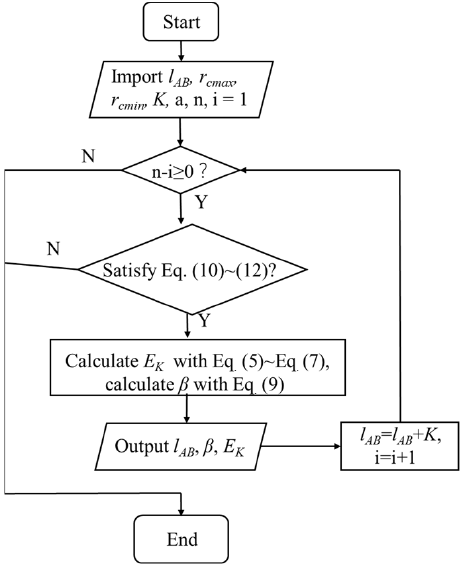
Figure 9. Flow chart of grabbing mechanism parameter optimization. Less than 1mm of the grasping error is enough for harvesting the hydroponic Chinese kale [27]. On the basis of preliminary tests, θ is set as 60 ◦ , a is 36mm, K is 5mm, n is 20, and initial l AB is 50mm. In Table 1, the r cmin and r cmax of the grabbable area of the hydroponic Chinese kale are 3.60 mm and 8.30 mm, respectively. The optimization program was run according to the flow chart in Figure 9, and iterative results of l AB , β , and grasping error E k are shown in Table 2. It shows that with an increase in the iteration times, the grasping error decreases; after the seventh iteration, the grasping error reduces to less than